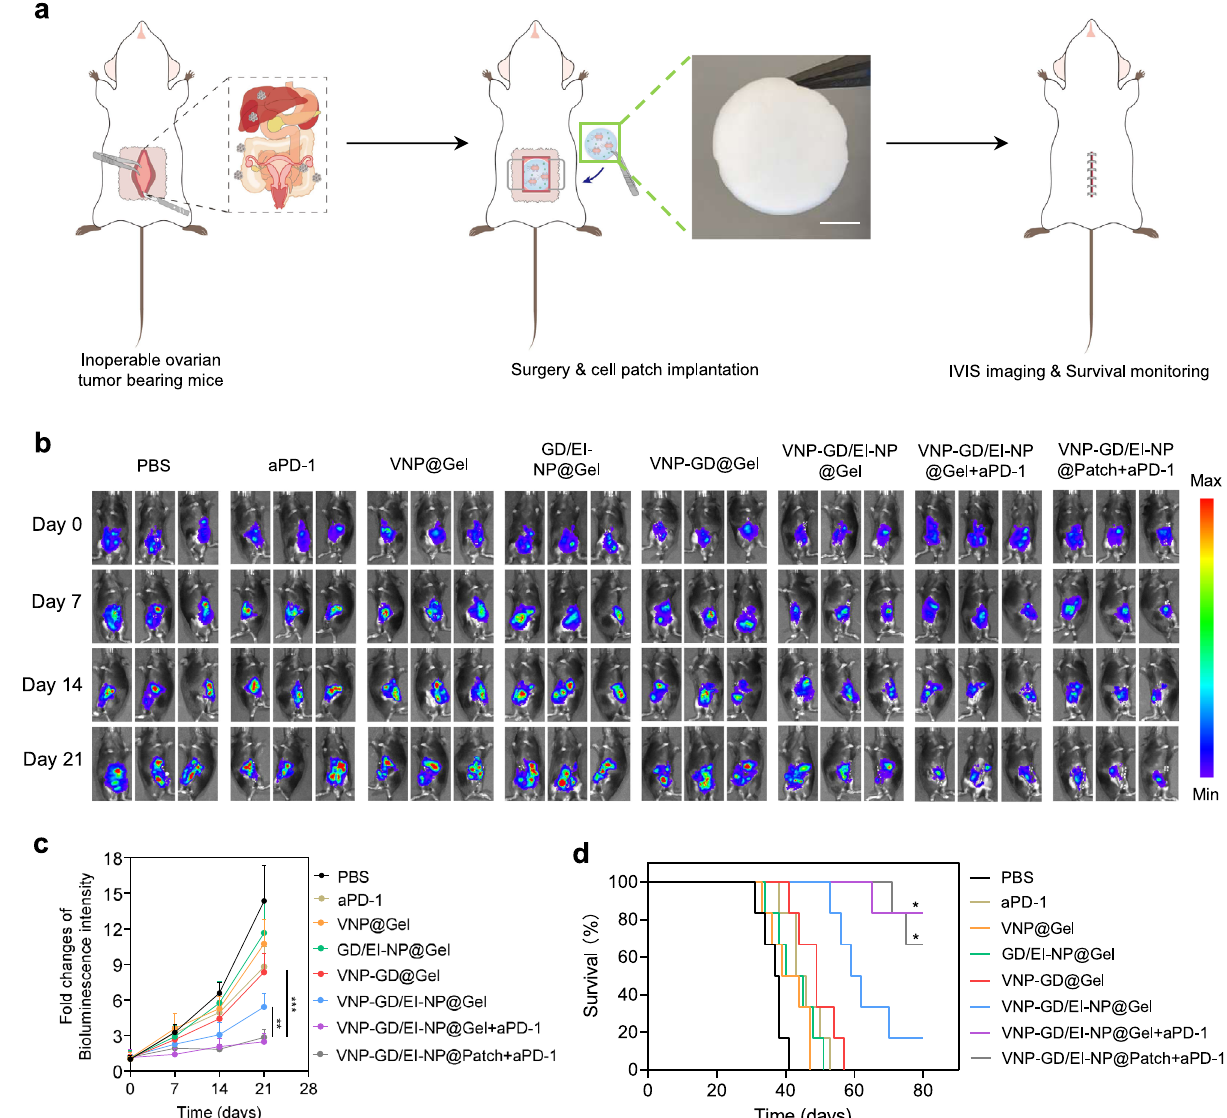
Fig. 6 | Antitumor ef fi cacy of implantable cell patch in inoperable ovarian cancer. a Schematic illustration of the implantation of the cell patch for the treatment of inoperable ovarian cancer and the representative image of the lyo- philized hydrogel patch loaded with EI-NP. Scale bar: 5mm. b Representative bio- luminescence images of the mice bearing ID8-Luc ovarian tumors after different treatments of PBS, aPD-1, VNP@Gel, GD/EI-NP@Gel, VNP-GD@Gel, VNP-GD/EI- NP@Gel, VNP-GD/EI-NP@Gel+aPD-1 and VNP-GD/EI-NP@Patch+aPD1 ( n =6 mice). c Data analysis of the normalized intensity of the bioluminescence signals of the mice with different treatments. Data are presented as mean ± s.d. ( n =6 mice) and analyzed with two-way ANOVA followed by Tukey ’ s multiple comparisons